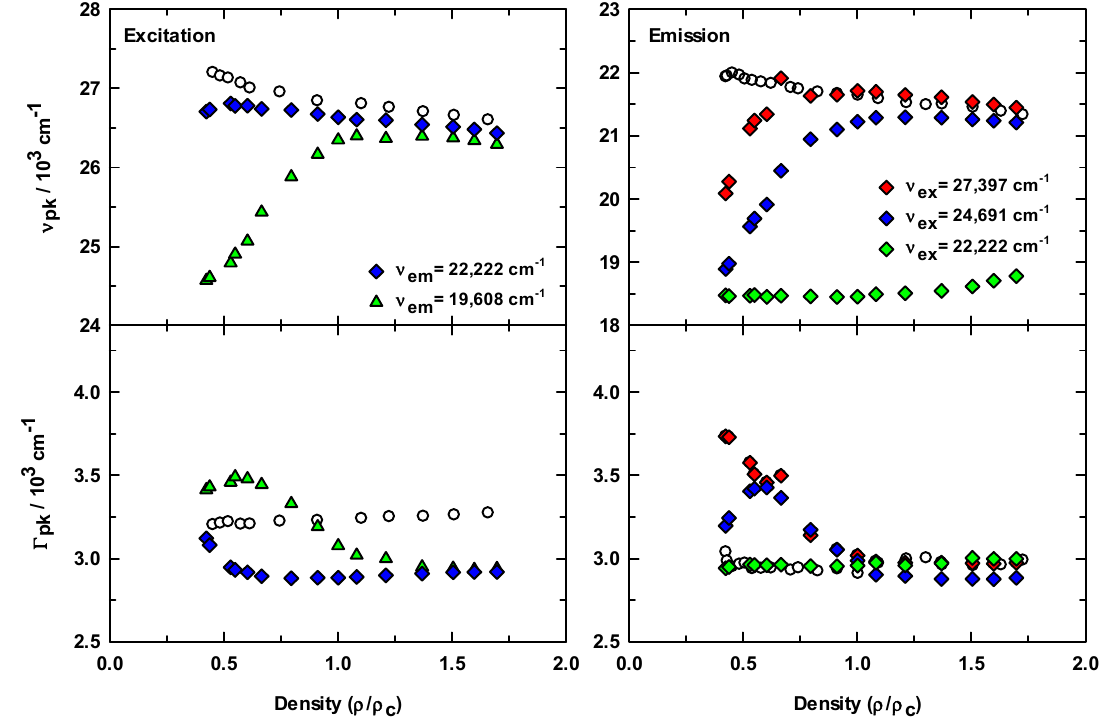
Figure 4. C153 spectral parameters in the absence (open circles) and presence (filled symbols) of [P 6,6,6,14 ] + [Tf 2 N] − . The upper panels show the first moments of excitation and emission frequencies. Emission data were from several excitation energies, 27,397 cm − 1 (red symbols), 24,691 cm − 1 (blue symbols), and 22,222 cm − 1 (green symbols) whereas the lower panels give FWHM bandwidths. Uncertainties in peak positions are less than ~180 cm − 1 and widths are less than 200 cm − 1 .